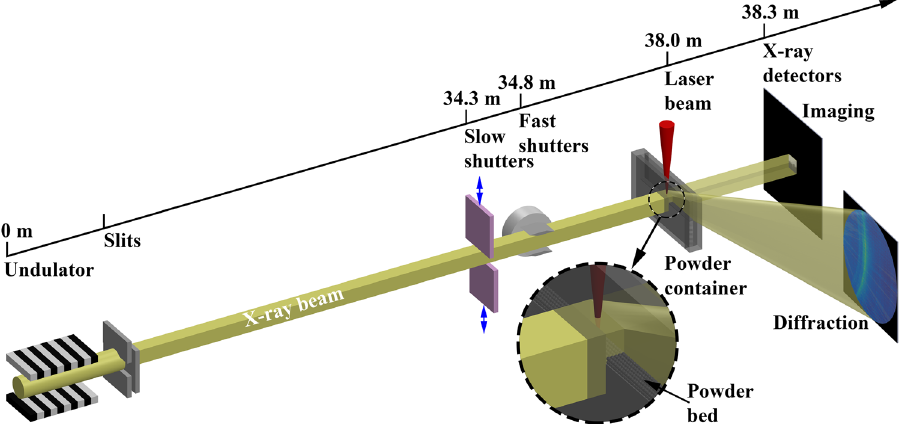
Figure 1. Schematic of the high-speed X-ray imaging and diffraction experiments on laser powder bed fusion process at the 32-ID-B beamline of the Advanced Photon Source. A short-period undulator generates a pseudo pink beam with first harmonic energy of 24.4 keV ( λ = 0.508 Å). The laser impinges on the miniature powder bed sample from the top, and the X-rays penetrate the sample from the side. The imaging and diffraction detectors are placed downstream, about 300 mm away from the sample. The inset surrounded by the dashed circle enlarges the view of the laser-sample and X-ray-sample interaction. The distance of each component from the source is labeled on